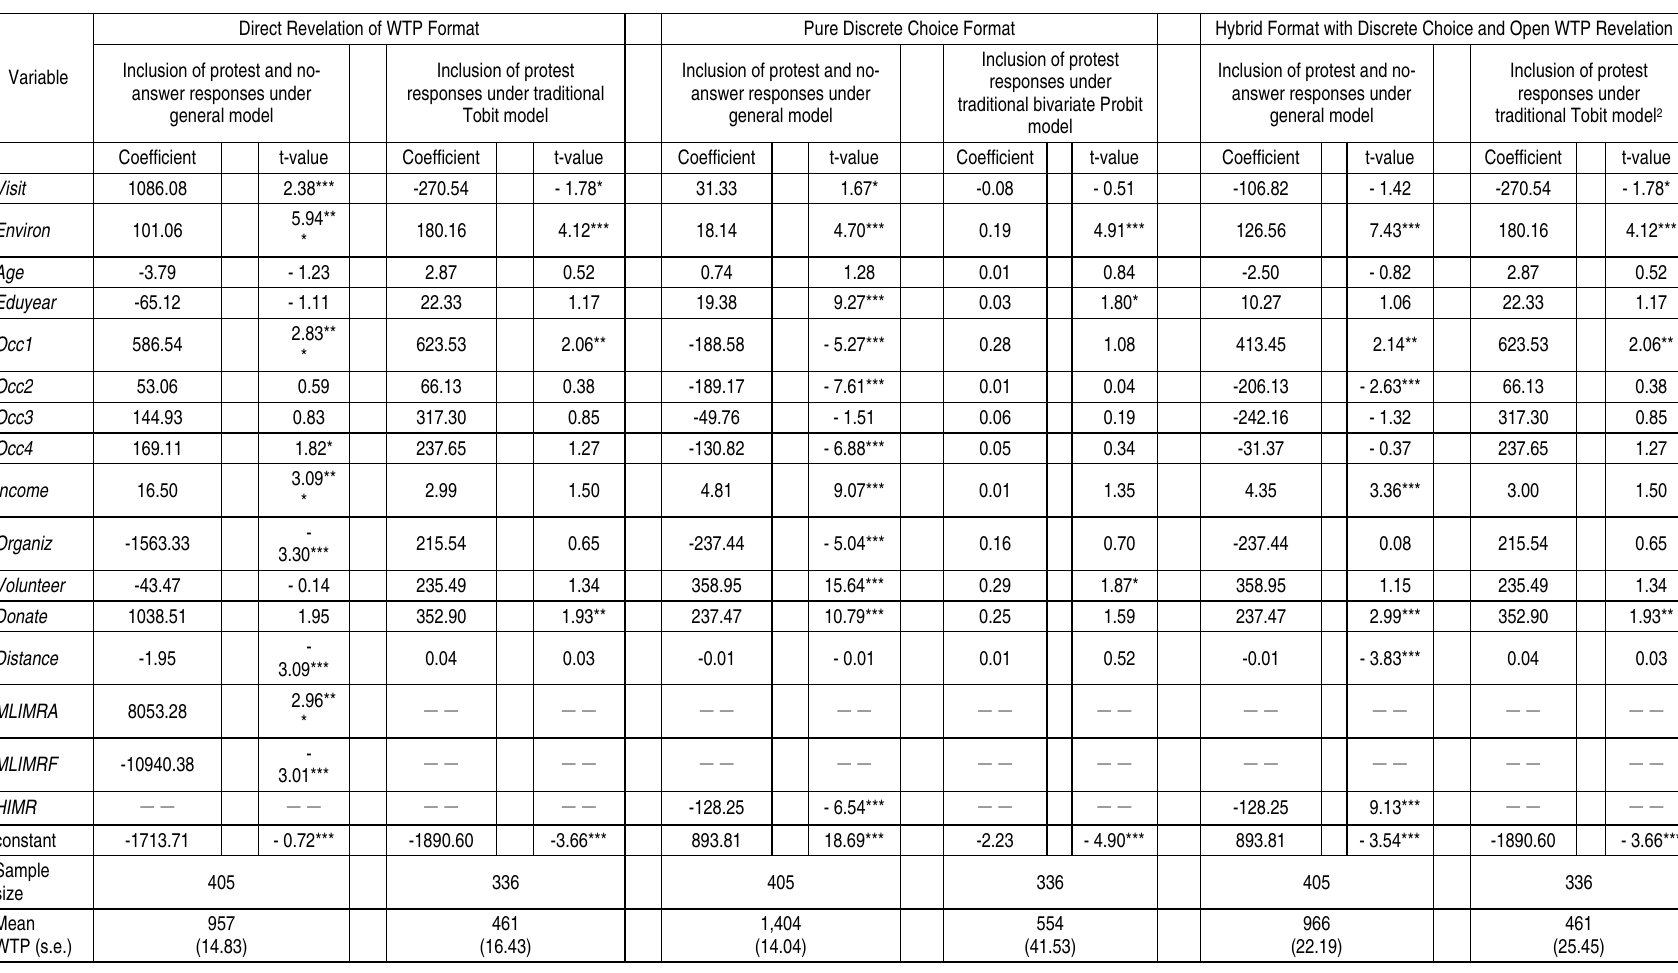
Table 3. Comparison of estimation results of general model with inclusion of non-protest, protest, and no-answer responses and traditional Tobit